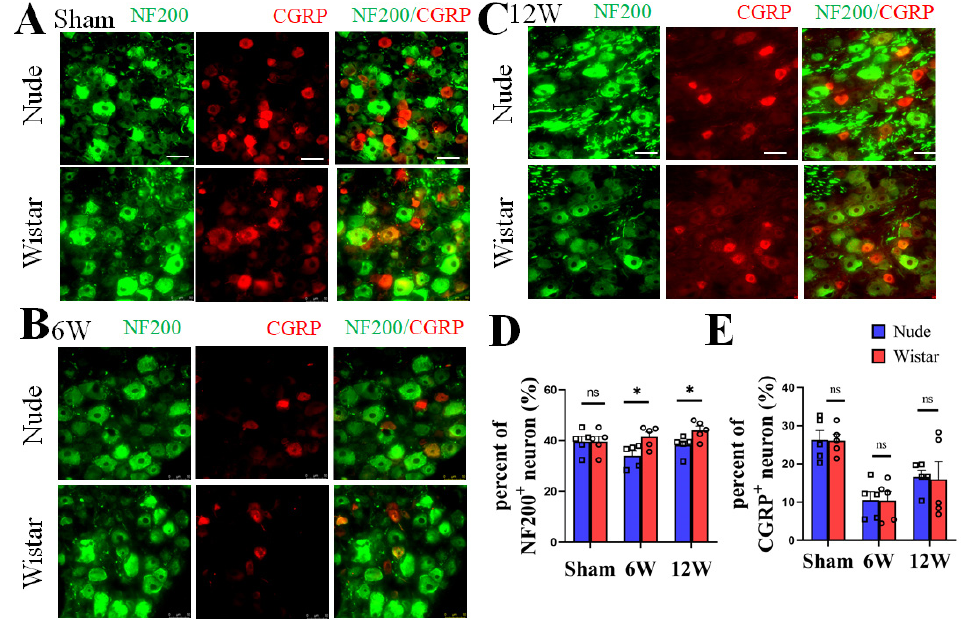
Figure 3. The expression of NF200+ and CGRP+ neurons in DRG. Representative immunofluorescence images of NF200+ and CGRP+ neurons in DRG at sham ( A ), 6 ( B ), and 12 weeks ( C ). ( D ) Quantitative analysis showed the percentage of NF200+ neurons in DRG of Wistar rat was higher than nude rat both at 6 and 12 weeks. There was no difference observed in the percentage of NF200+ neurons in the DRG in the sham groups. ( E ) Quantitative analysis showed that the nude and Wistar rat groups at 6 or 12 weeks, as well as the two sham groups, exhibited no difference in CGRP+ neurons. Scale bar 50 μ m. Two-way ANOVA with Bonferroni’s post-test was applied. Sample size: n = 5 * p < 0.05; nude rats vs. Wistar